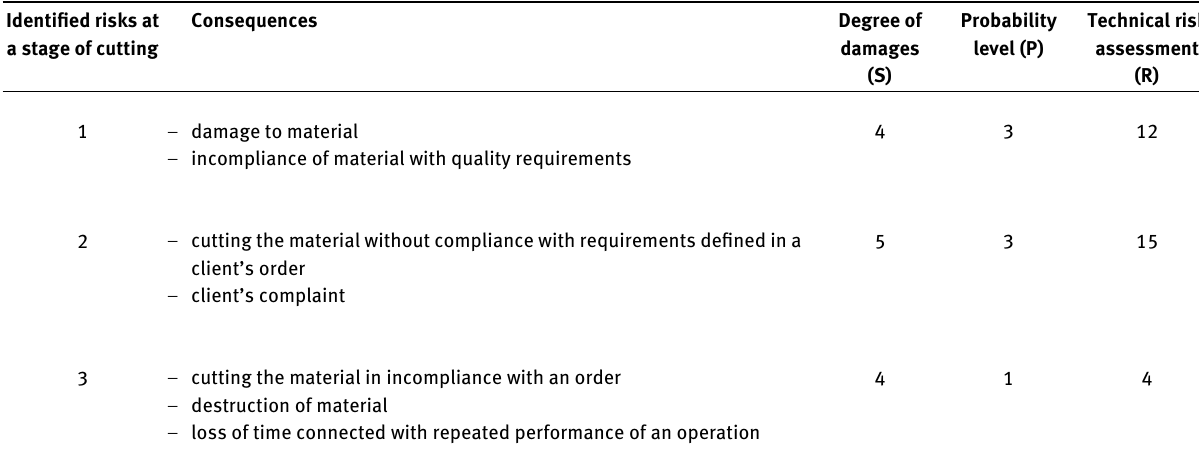
Table 2: Assessment of technical risk for indicated hazards at a stage of cutting Identified risks at a stage of cutting